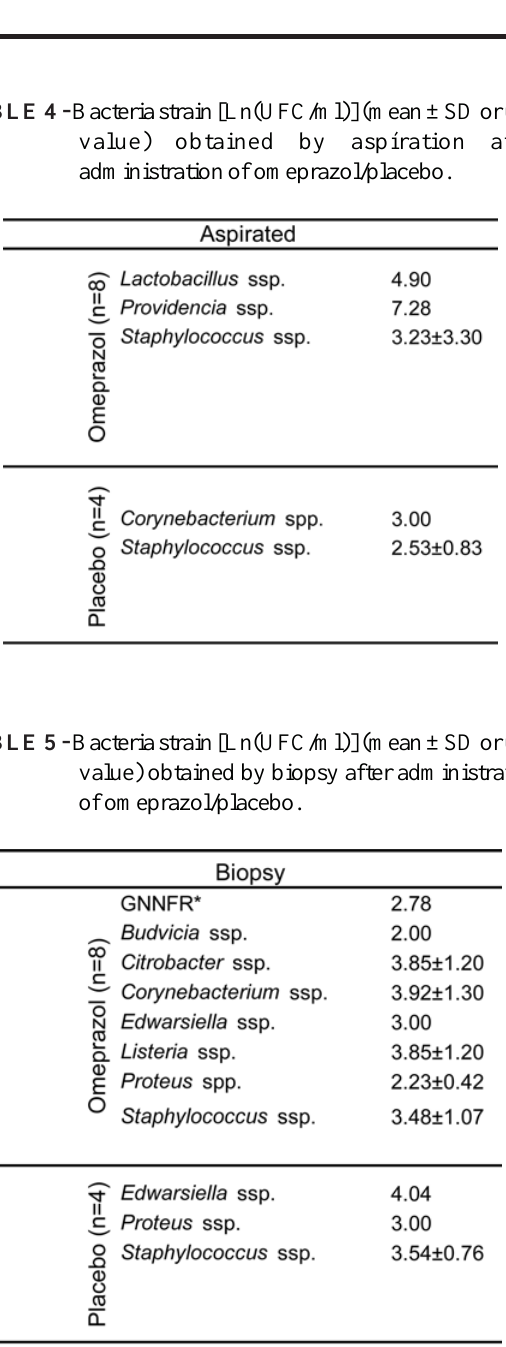
FIGURE 1 - Amount of bacteria [Ln(UFC/ml)] according to each collection method after using omeprazol/ placebo (Kruskal-Wallis test).